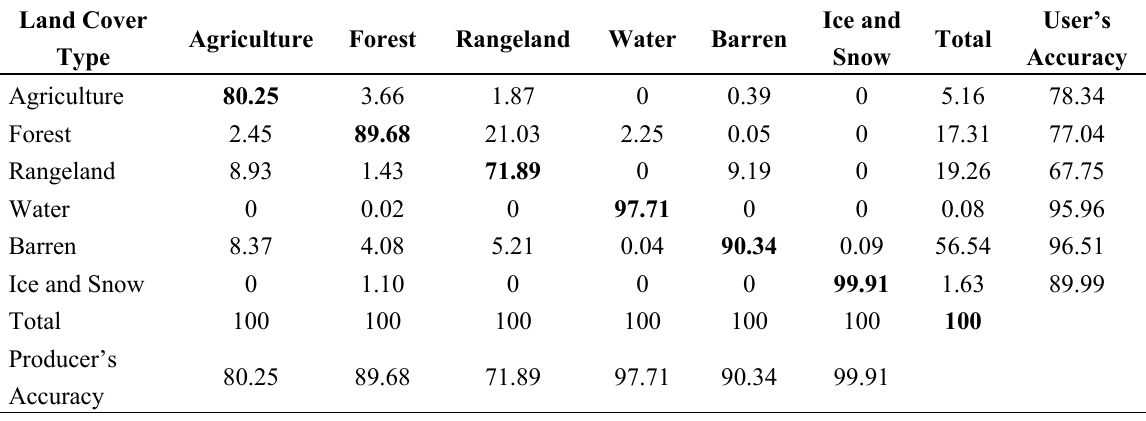
Table 3. Contingency table of derived 2000 LULC map.